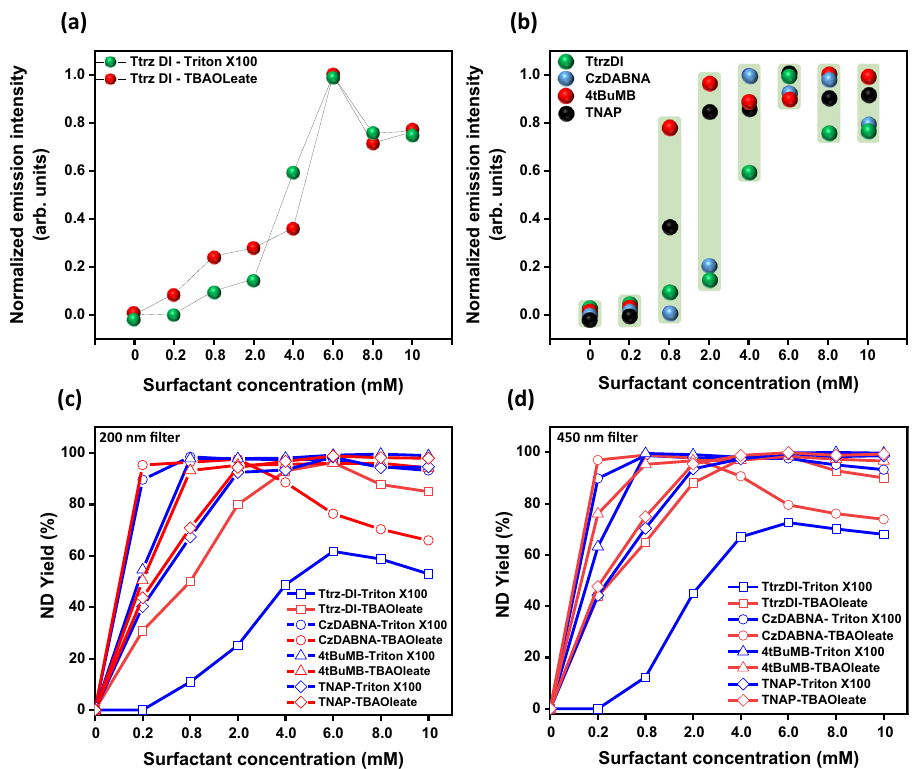
Fig. 3 PL intensity and yield. a Relative PL intensity of Ttrz-DI nano-dot dispersions with variable concentrations of Triton X-100 and TBA oleate surfactants, where the concentration of Ttrz-DI fl uorophore was kept constant at 0.01 mM. b Summary of PL spectra of Ttrz-DI, CzDABNA, TNAP, and 4tBuMB nano-dot dispersions with varyiable concentration of Triton X-100 surfactant. c Yield of organic nano-dots of less than 200 nm size at different concentrations of Triton X-100 and TBA oleate. d Yield of organic nano-dots of <450 nm size at different concentrations of both Triton X-100 and TBA